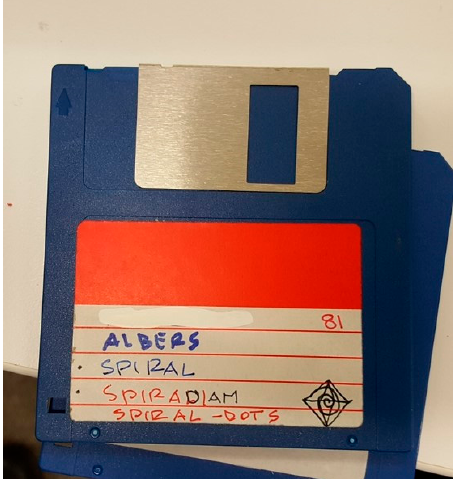
Figure 31. One of Ostoja’s floppy disks, showing his descriptive use of line drawings to label disks, and use of white-out on disk labels. SLSA disks taken in Flinders Computer Archaeology Lab. Image courtesy Melanie Swalwell. Published with permission of SLSA.